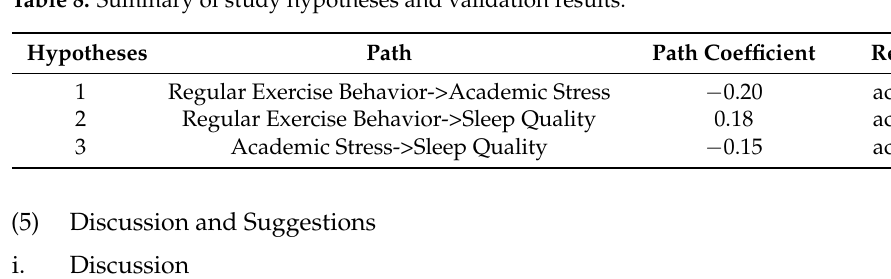
Table 8. Summary of study hypotheses and validation